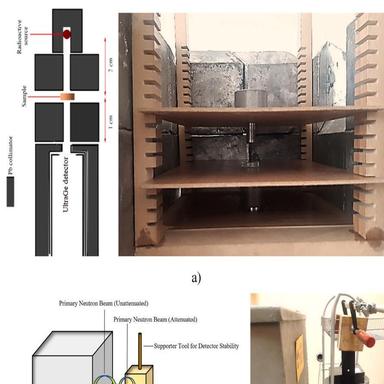
(a–b). Experimental setup for (a) gamma-ray and (b) neutron transmission measurements.